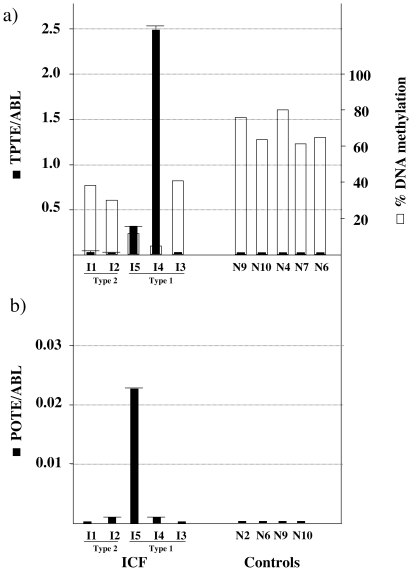
Heterochromatic genes escape silencing in ICF patients.Black bars represent gene expression of two heterochromatic gene families that were expressed in ICF patients: TPTE (a) and POTE (b). The ABL gene was used to normalize cDNA amounts. I, ICF patients; N, controls. Type 1, 2 are ICF patients with and without known mutations in the DNMT3B gene, respectively. For TPTE (a) we superposed the percentage of DNA methylation (white bars).